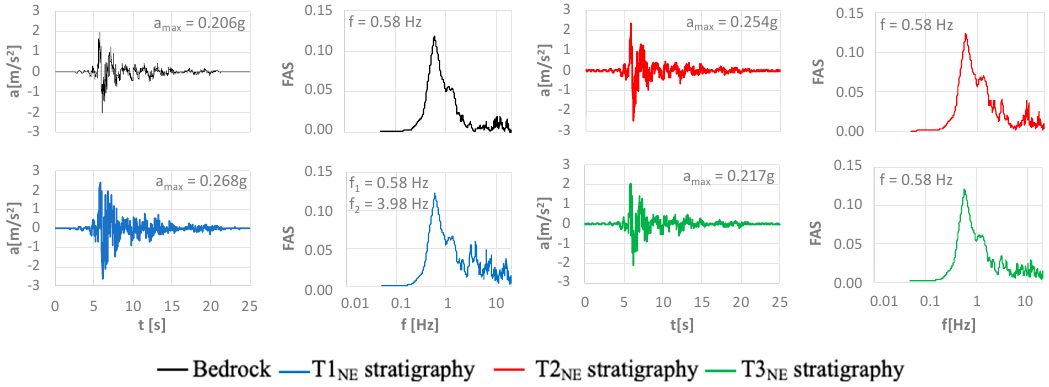
Figure 6. Results of 1D response analysis for the 1818 seismic input for the northeast area.